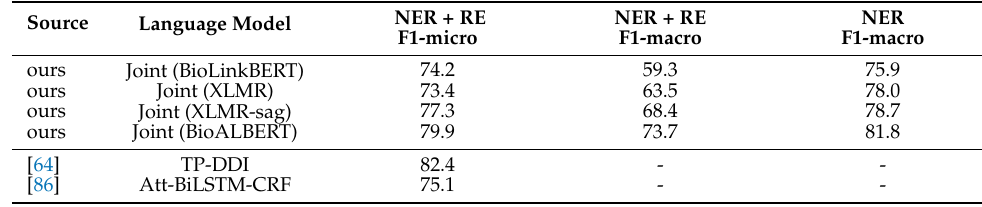
Table 11. An accuracy of NER and RE tasks on DDI dataset (joint